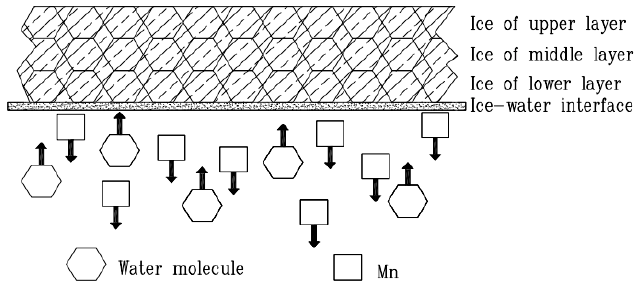
Figure 3. Migration of Water Molecules and Mn.